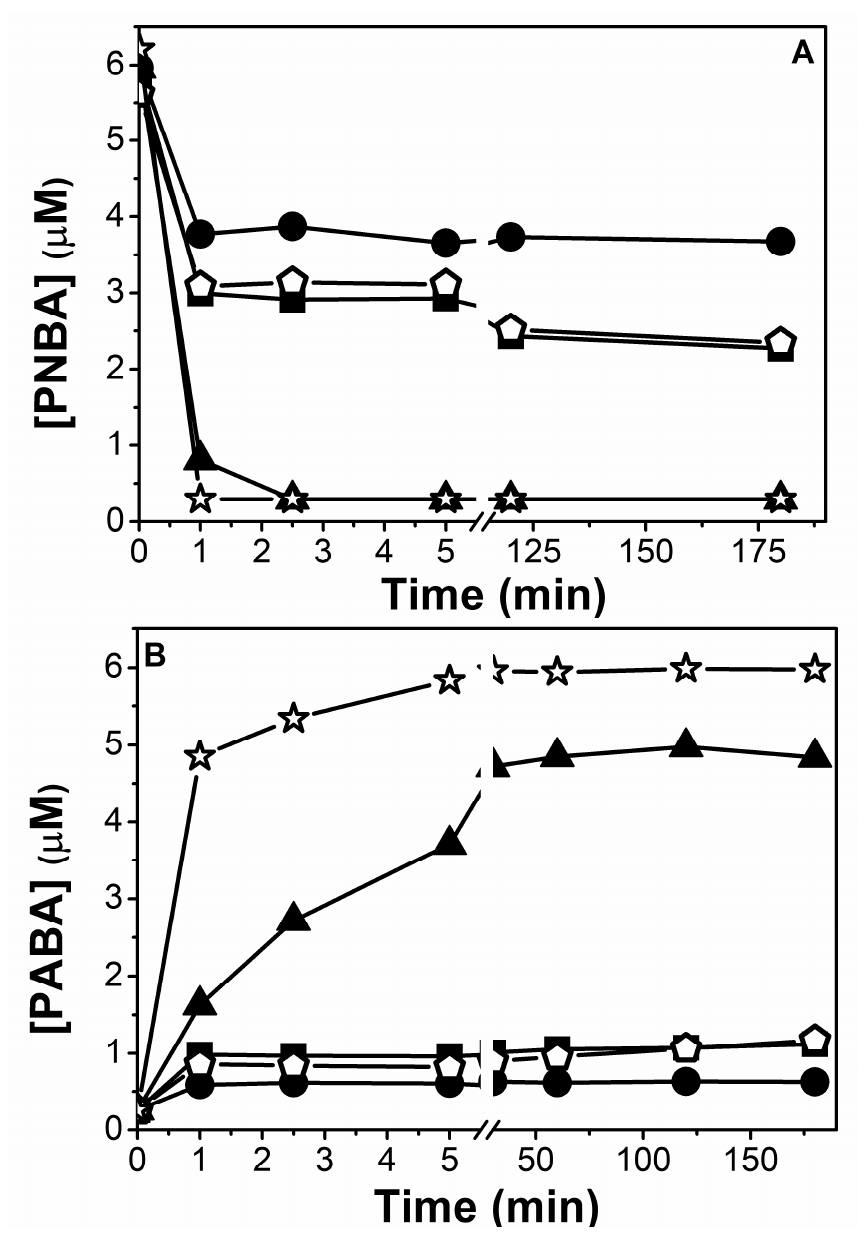
Figure 4. Water matrix effect. PNBA 6 µM reduction with mZVI 1.4 g/L at initial pH 3.0 in DW, ( A ) PNBA and ( B ) PABA kinetics, respectively. Symbols are represented by: DW alone ( ⬠ ), DW + Cl − 212 mg/L ( ● ), DW + SO 42 − 270 mg/L ( ■ ), DW + TIC 34 mg/L ( ▲ ), and DW + N 2 purging ( ☆ ).